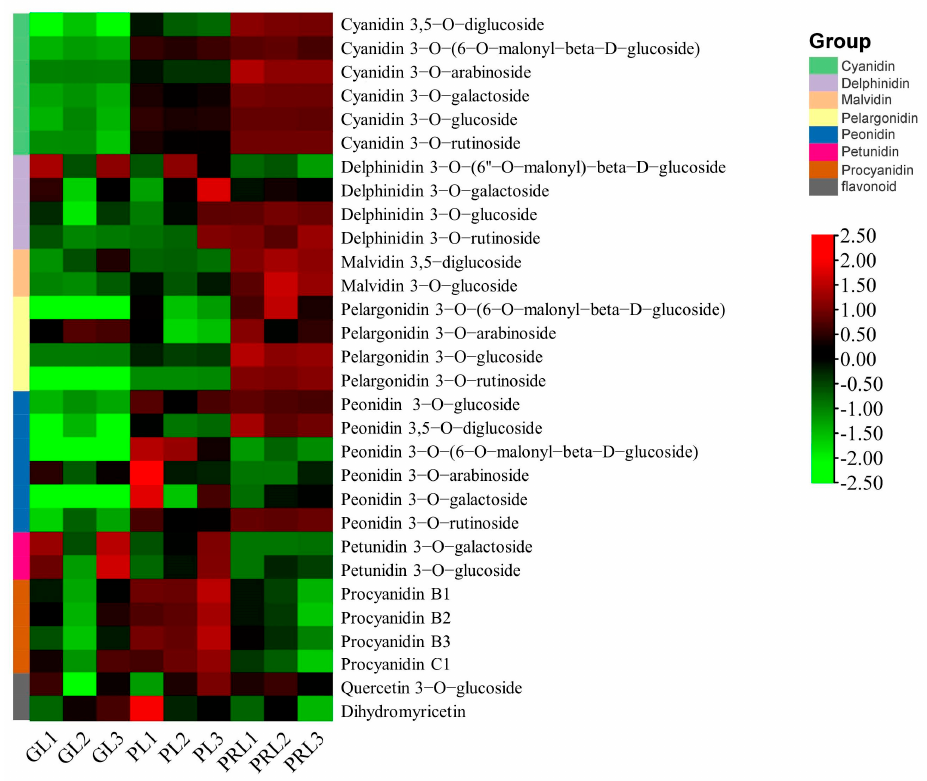
Figure 3. Heatmap of metabolites related to cyanidin, peonidin, delphinidin, pelargonidin, procyanidin, flavonoid, malvidin and petunidin in GL, PL and PRL. The marker on the right side of heatmap represents the names of each anthocyanin composition obtained by high–performance liquid chromatography (HPLC). Color scale from green to red in the heatmap represents the normalized metabolite contents (from low to high) using Row Z − score. GL, green leaves; PL, purple leaves; PRL, purple − red leaves.